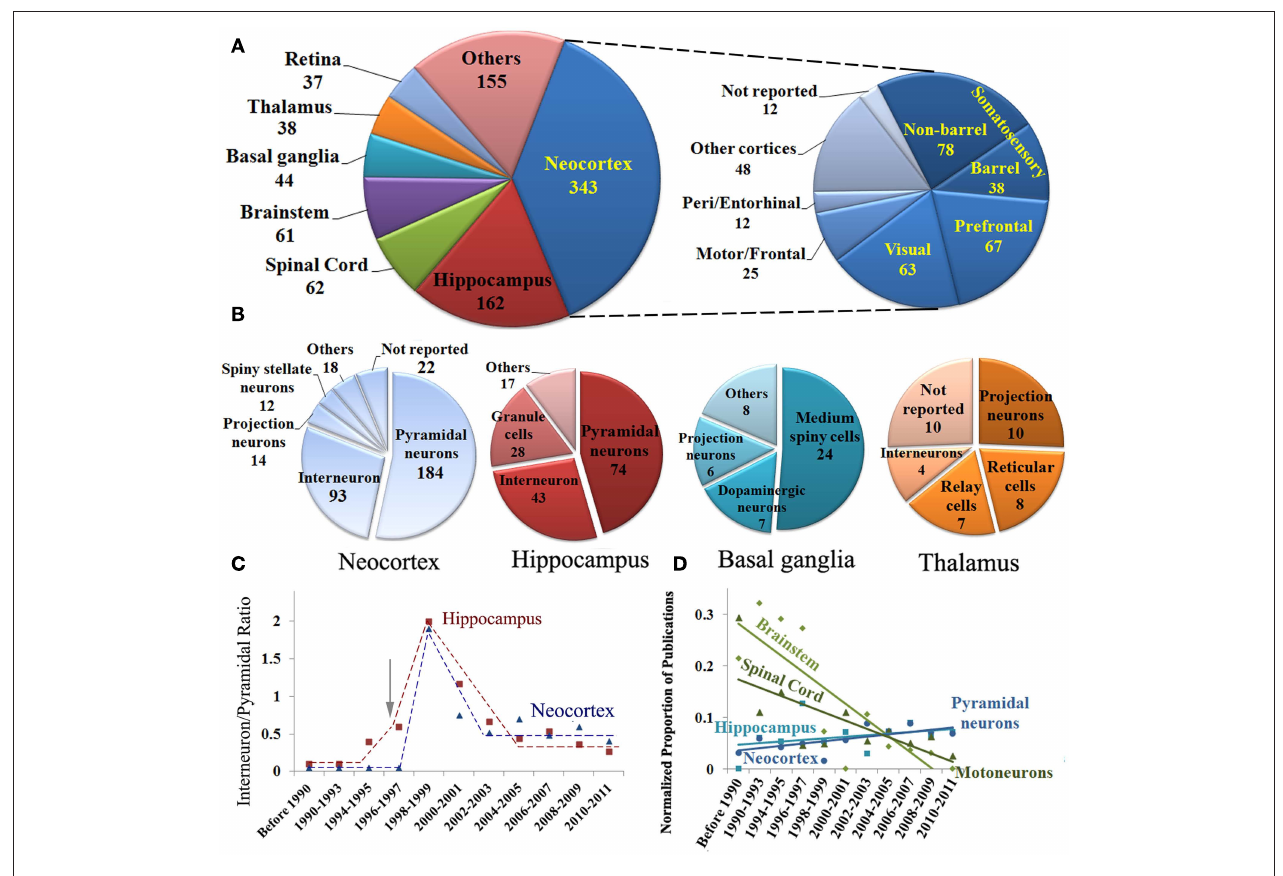
pyramidal cells reconstructed in the hippocampus and neocortex, highlighting the surge of interest in interneurons in the late 1990s (arrow); (D) Chronological analysis of identified publications by brain region and cell type demonstrating selected upward and downward